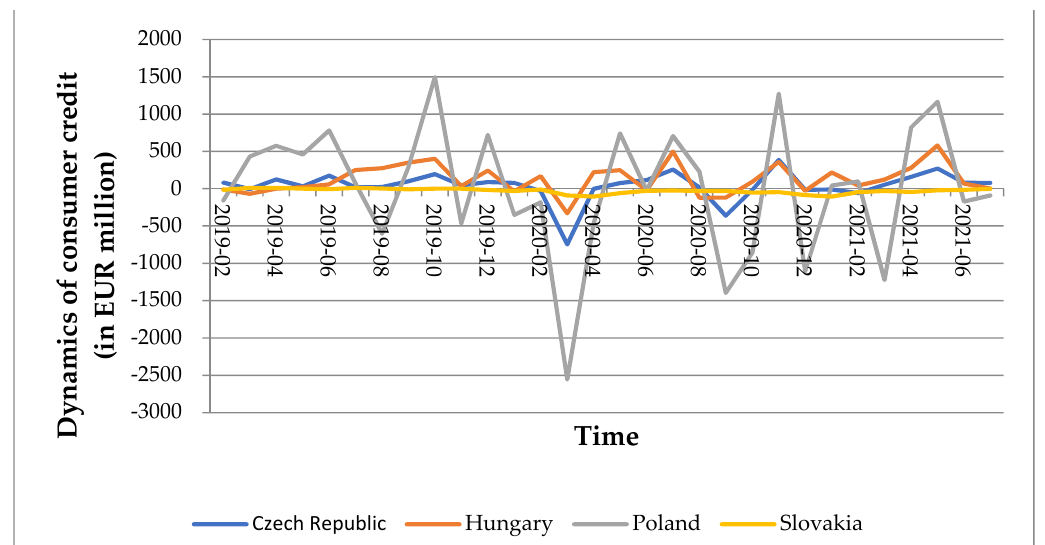
Figure 2. Dynamics of consumer credit in V4 countries (month/month, in EUR million). Source: (https://sdw.ecb.europa.eu/browse.do?node=9691311 accessed on 25 September 2021).